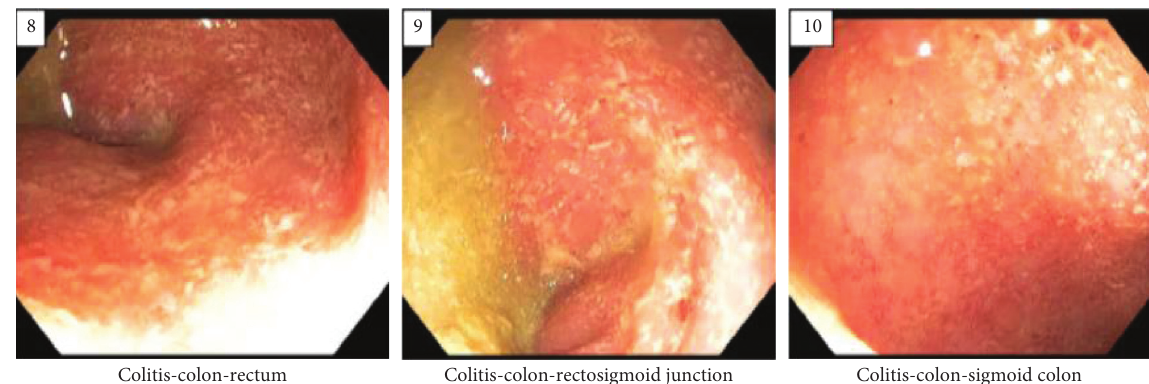
Figure 1: Colonoscopy showing colitis at the rectum, rectosigmoid junction, and sigmoid colon.